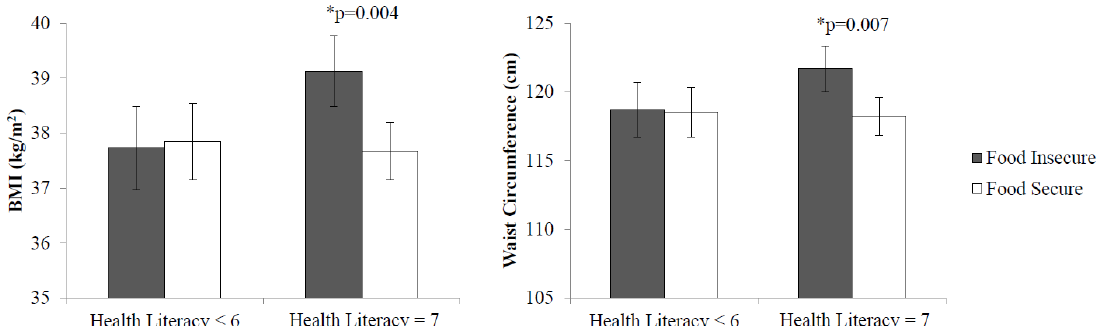
Figure 1. Adjusted Mean Adiposity by Food Security Status and Sex in PROPEL Patients. * indicates statistical significance ( p < 0.05). BMI, body mass index.